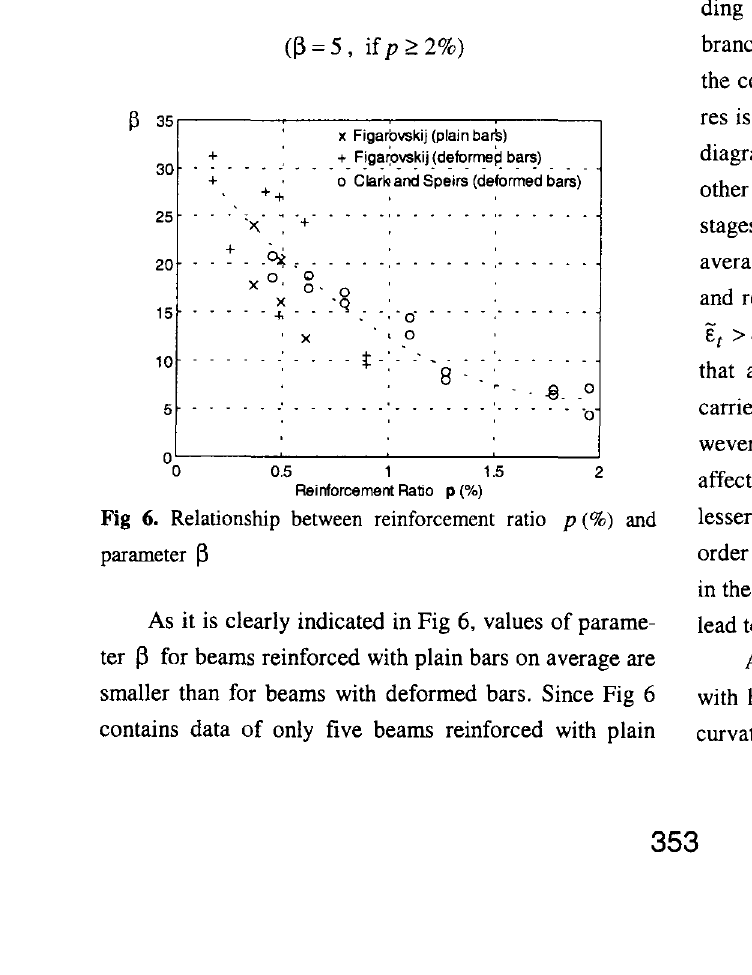
Fig 6. Relationship between reinforcement ratio p (%) and parameter